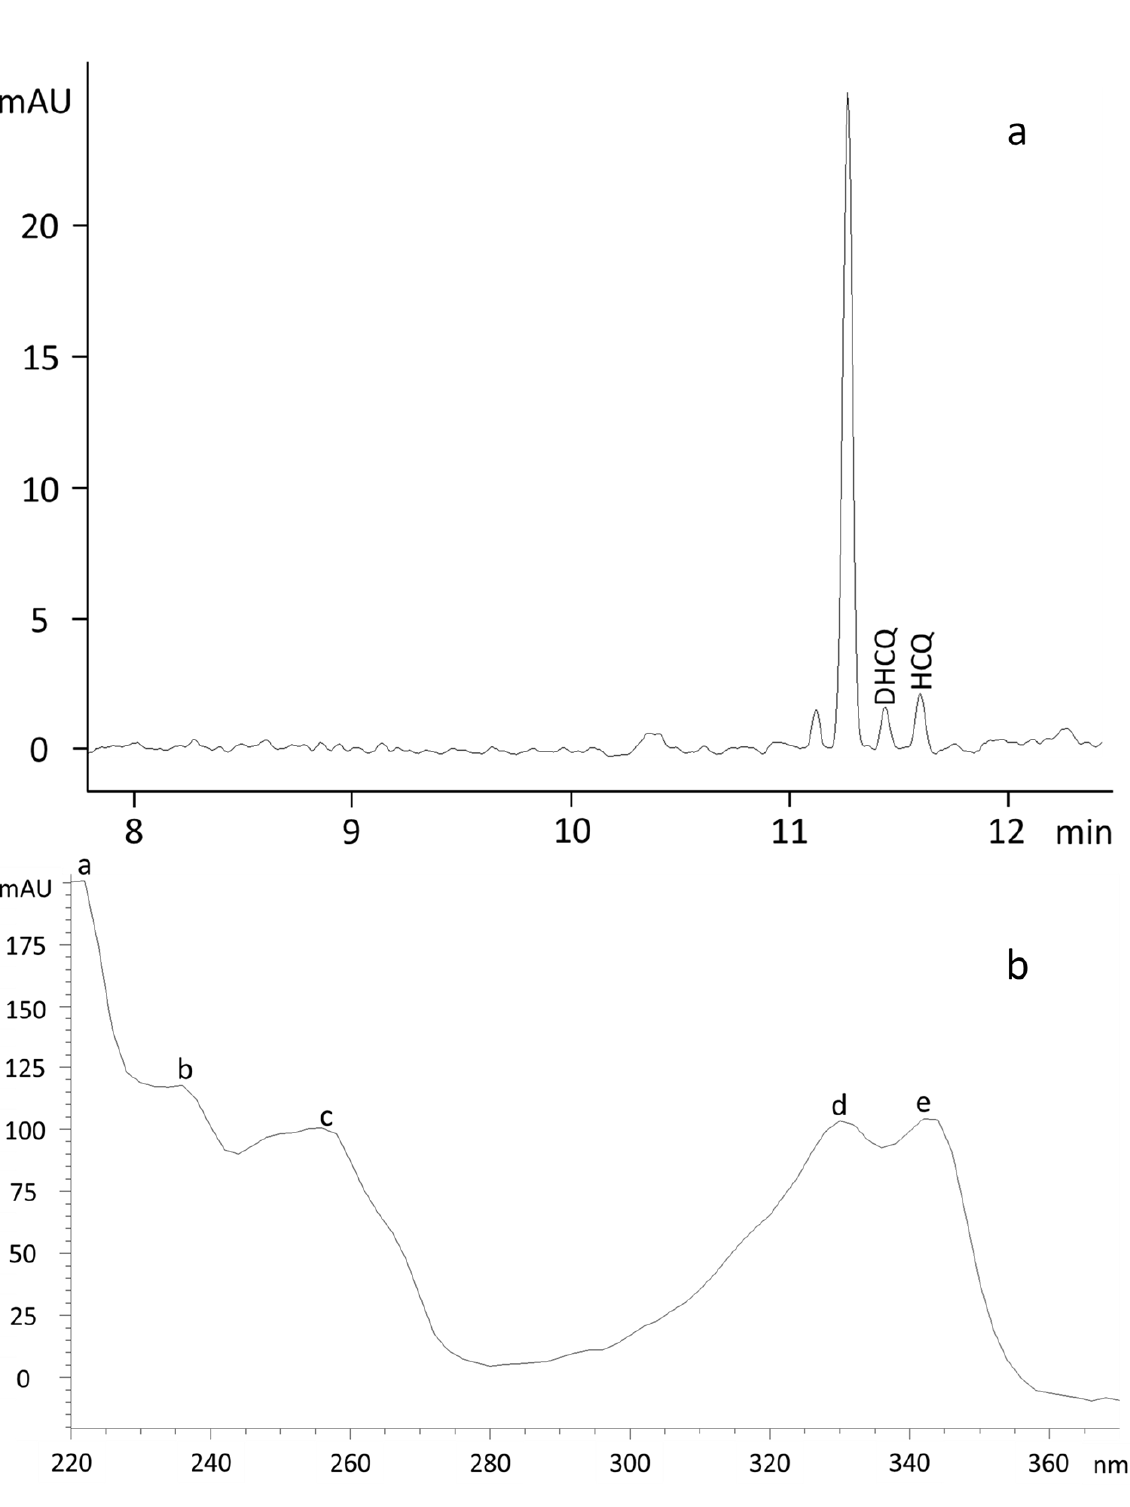
Figure 2. ( a ) Electropherogram of a clinical sample obtained using as a BGE, ( a ) a mixture of an aqueous 55 mmol/L TRIS solution brought to pH 2.6 with H 3 PO 4 and MeOH (85:15), and a voltage and a temperature of separation of 30 ◦ C and 20 kV and ( b ) UV-Vis spectra of analytes recorded in the range of 190–400 nm with maximum absorbance at (a) 220, (b) 236, (c) 256, (d) 329, (e) and 343 nm.